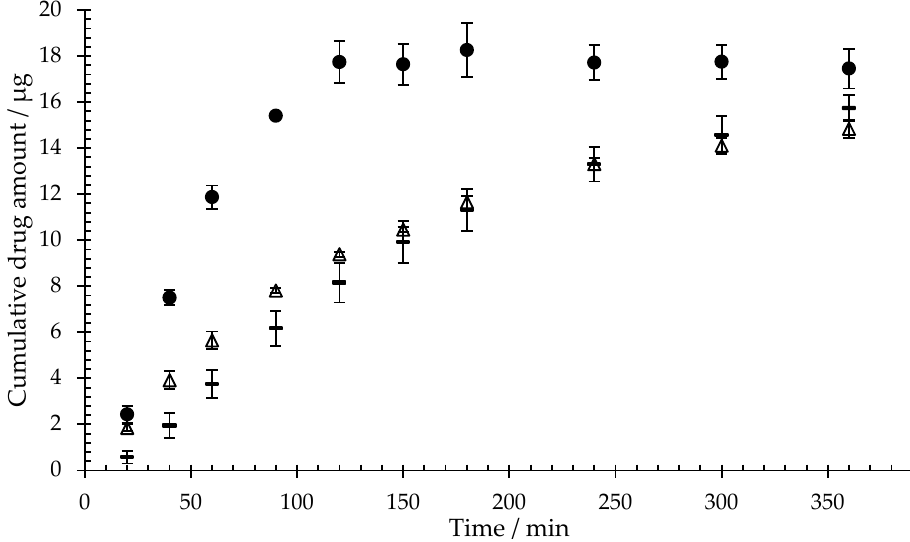
Figure 5. Cumulative diffusion of 20 µg sodium fluorescein across a mixed cellulose ester membrane covered with hydrogel samples or artificial saliva (300 µ L) over 6 h, • artificial saliva, △ 0.35% xanthan gum, ─ 0.65% sodium hyaluronate. Mean ± standard deviation. Each sample was measured in triplicate.